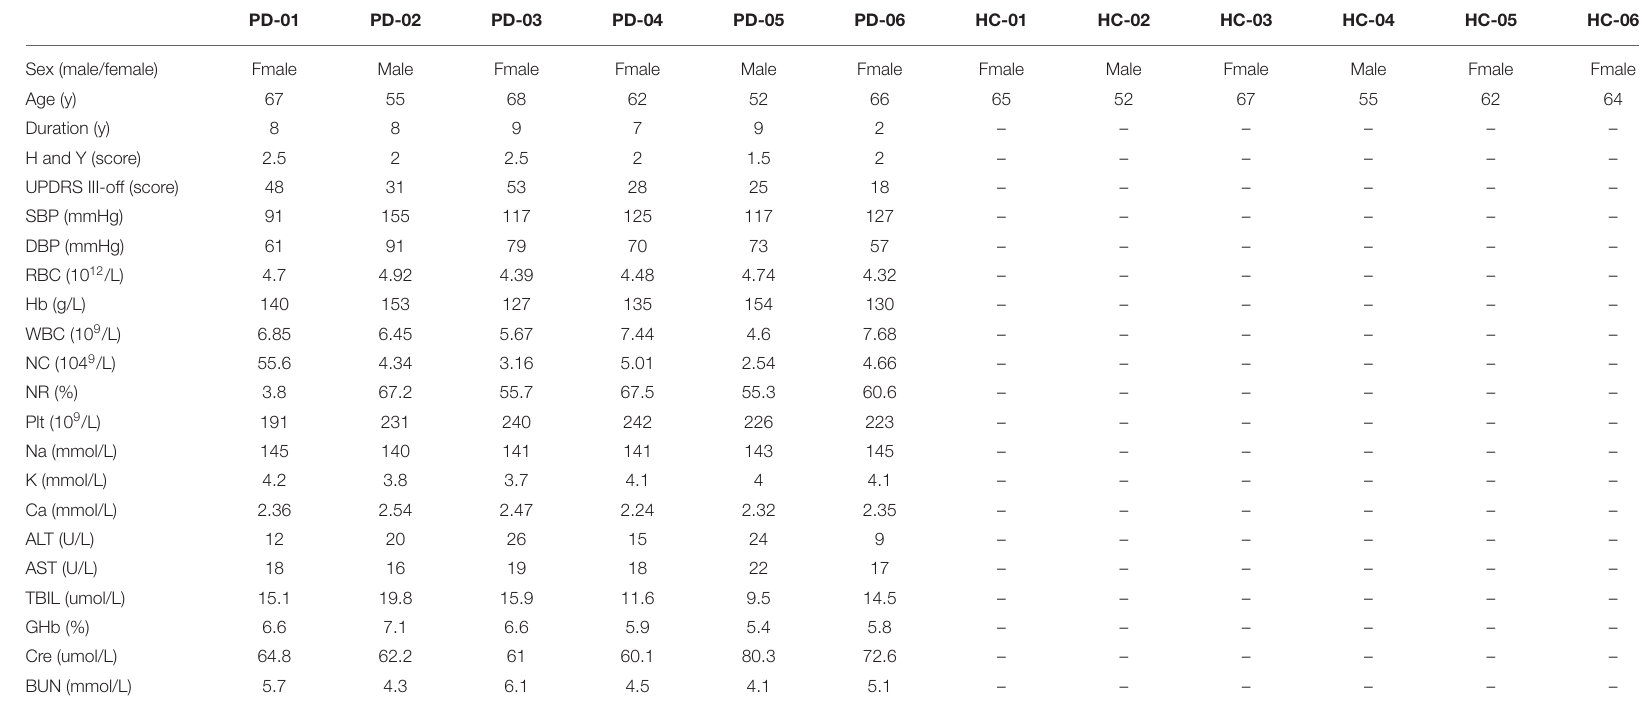
TABLE 3 | Clinical characteristics and blood biochemical features in PWPs and